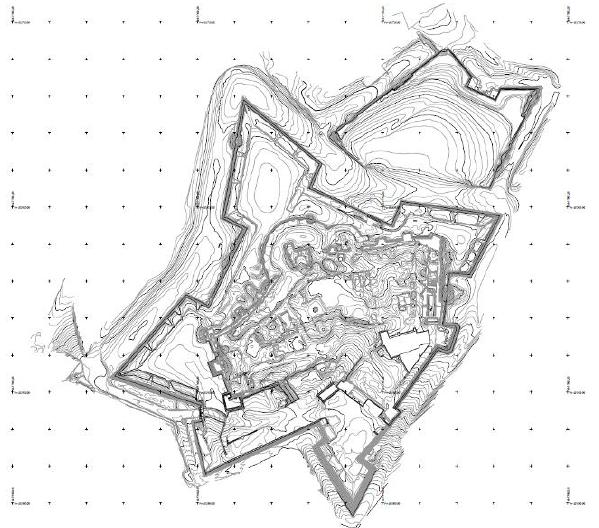
Figure 13. Topographic plan.